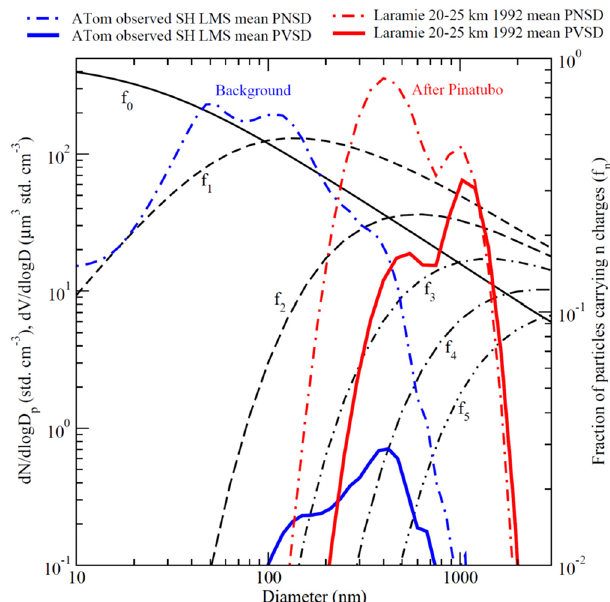
Figure 7. ATom 1–4 mean observed particle number size distribu- tion (PNSD or d N/ dlog D p ) and particle volume size distribution (PVSD or d V/ dlog D p ) in the SH LMS, balloon-borne measured mean PNSD and PVSD within a 20–25km altitude over Laramie, WY, in 1992, and fraction of particles carrying n ( n = 0, 1, 2, 3, 4, and 5) charges based on the modified Boltzmann equilibrium equa- tion (Clement and Harrison, 1992). Note that f n with n ≥ 1 includes both positive and negative charges, i.e., half of f 1 carries one nega- tive charge, while the other half carries one positive